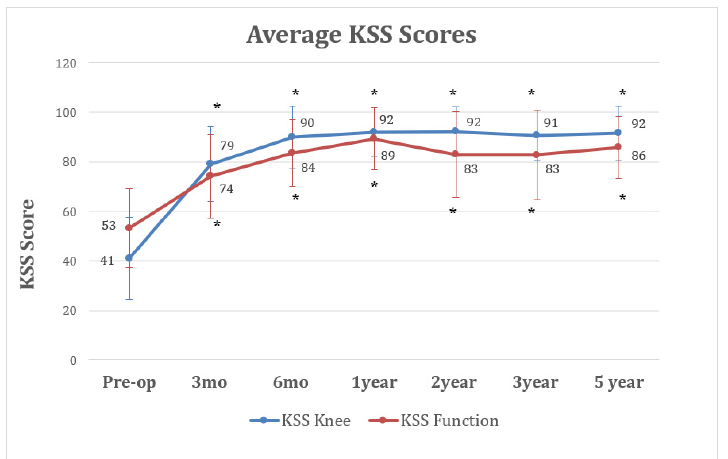
Figure 4. Average Knee Society Scores (KSS) for patients enrolled in the study, including the knee (blue) and function (red) subscores. The graphs reports averages +/ − SD. Asterisks (*) indicate statistical significance compared with the pre-op control, as determined by Student’s t -test ( p < 0.05). Similar results were observed in the analysis of the overall WOMAC-Score results. A